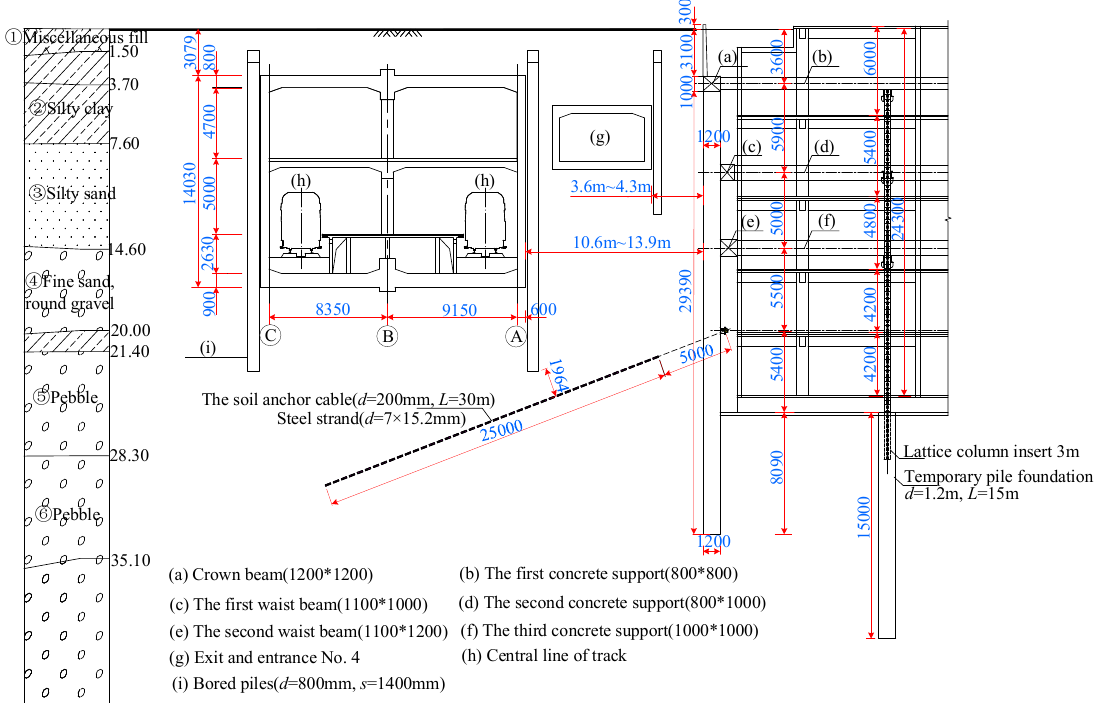
Figure 2. Sectional drawing of the relative position of the foundation pit and the station.